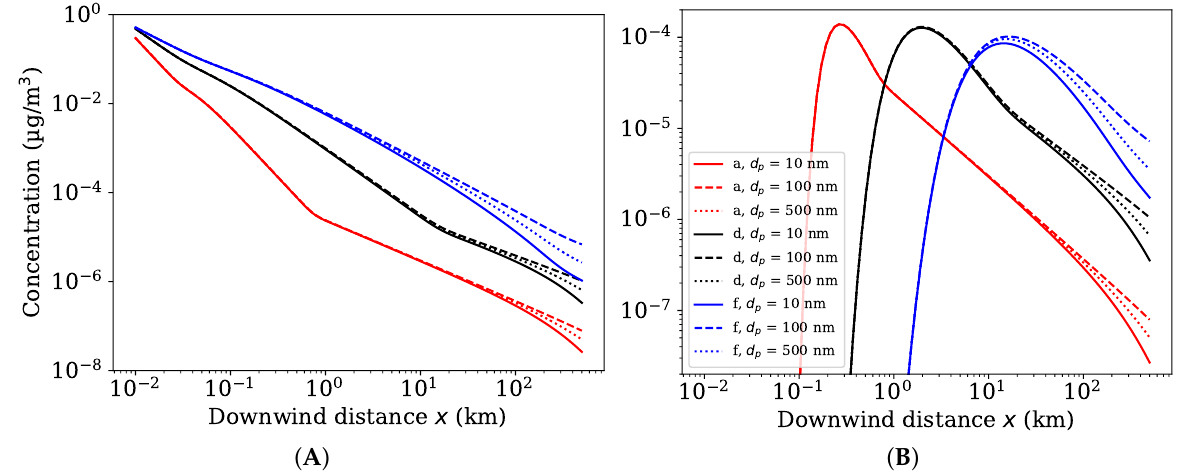
Figure 1. Ground level concentration (mass balance corrected) at the centerline of the plume as a function of downwind distance for a source height of ( A ) 2 m and ( B ) 50 m. Simulations for different particle sizes (10, 100 and 500 nm) and atmospheric stability classes (a, d, f) with a boundary layer height of 0.2 km and a wind speed of 10 m/s using Klug’s dispersion